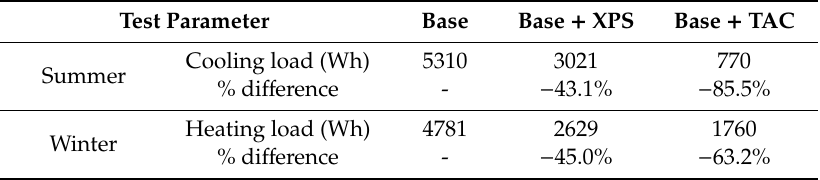
Table 2. Comparison of integrated cooling and heating loads.